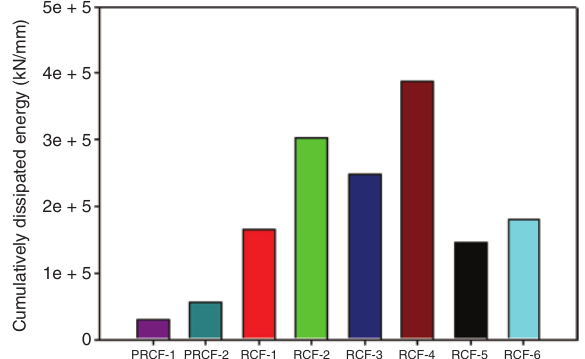
Figure 13: Cumulatively dissipated energy at 3.5% drift ratio level.